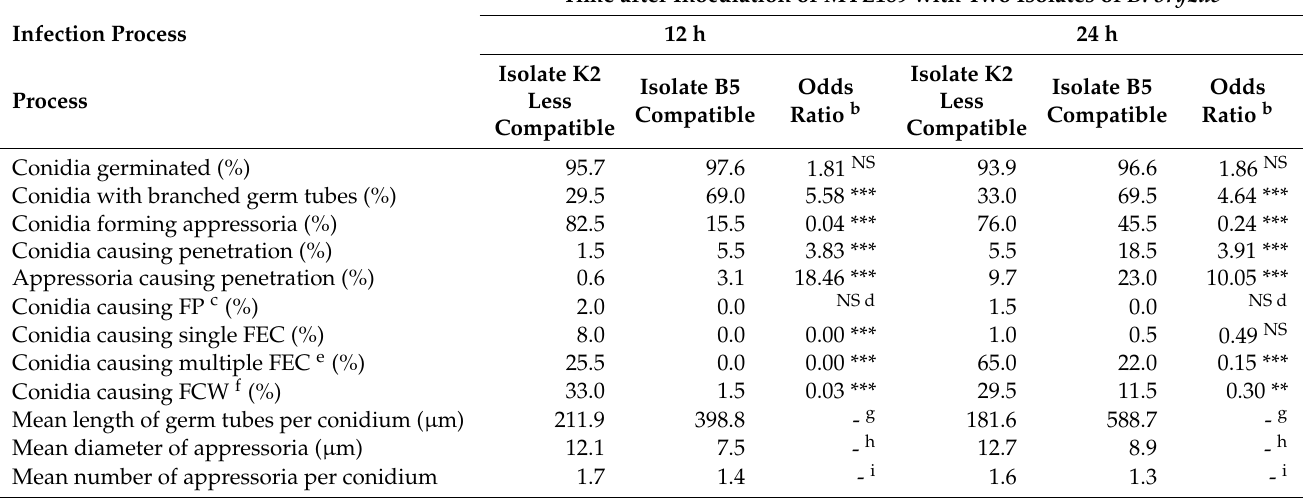
Table 1. Incidence of the various developmental steps in the infection process of compatible and less compatible interactions between Bipolaris oryzae and rice a